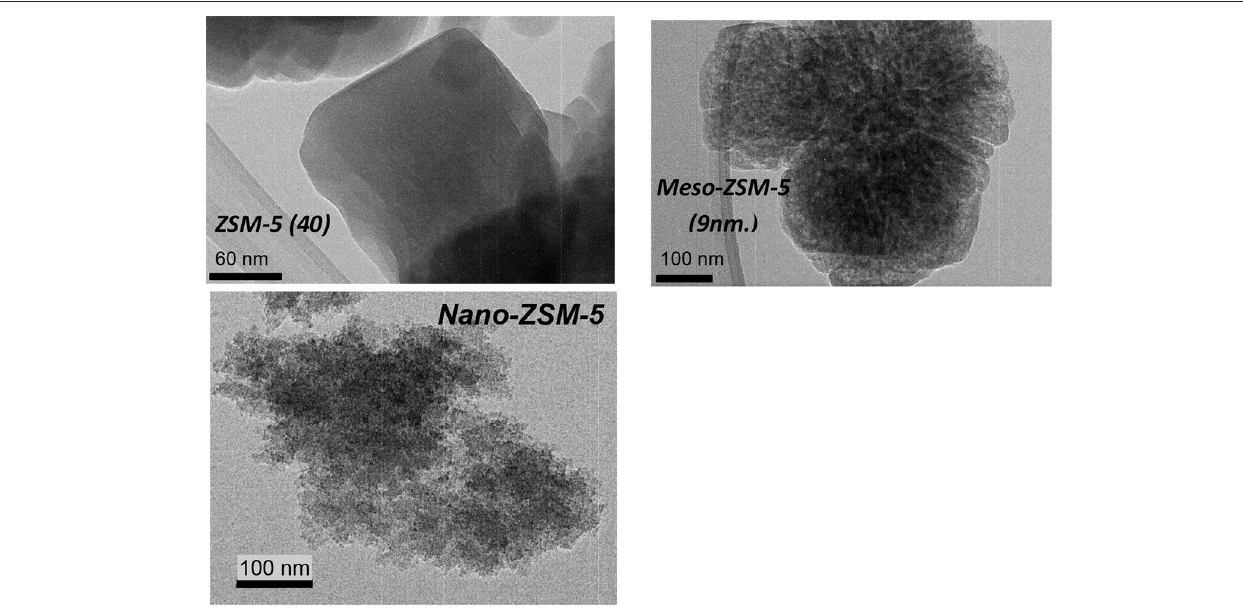
FIGURE 4 | Transmission electron microscopy (TEM) images of the conventional microporous ZSM5 (40) zeolite, the nanosized ZSM-5 and the alkaline-treated mesoporous ZSM-5